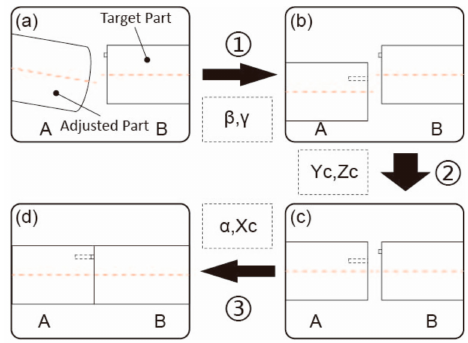
Figure 9. Measurement-adjustment